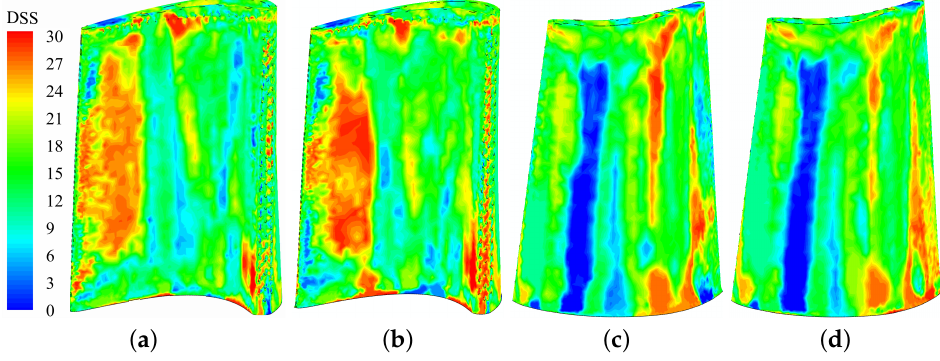
Figure 12. DSS distribution of the blade: ( a ) pressure side and ( c ) suction side under the rotating condition; ( b ) pressure side and ( d ) suction side under the stationary condition.